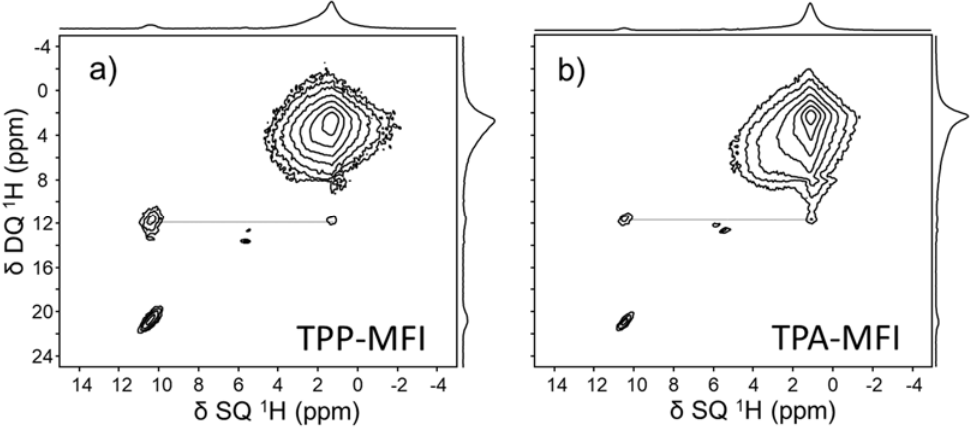
Figure 9. 1 H 2D DQ-SQ NMR spectra of ( a ) TPP-MFI and ( b ) TPA-MFI silicalite-1